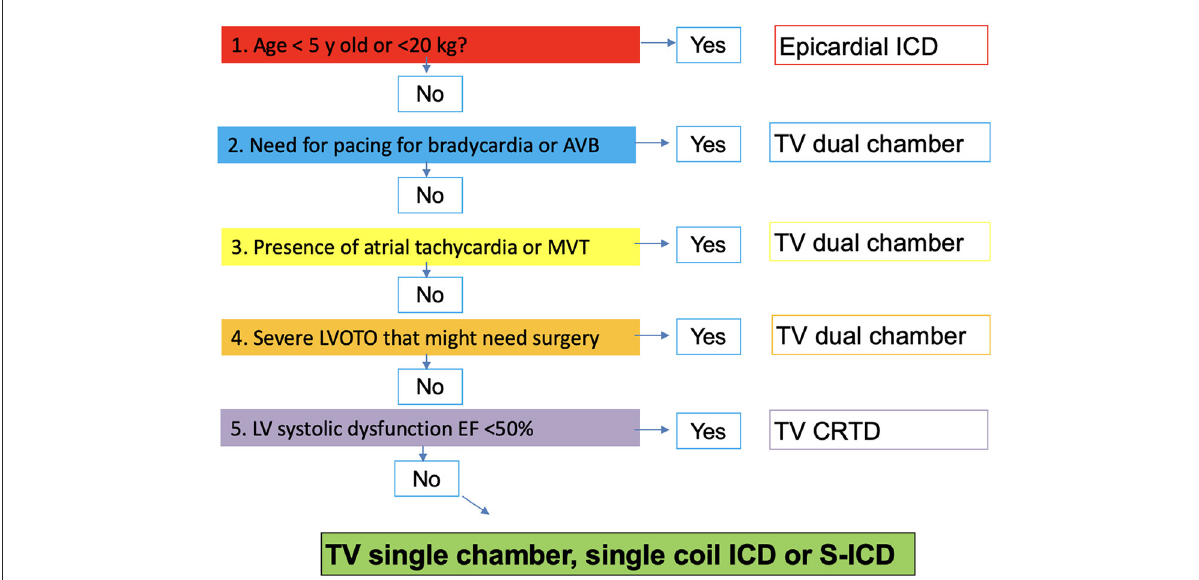
FIGURE4 Stepwise approach to guide selection of type of ICD implant in children with hypertrophic cardiomyopathy. ICD, implantable cardiac defibrillation; AVB, Atrioventricular block; TV, Transvenous; MVT, Monomorphic Ventricular tachycardia; LVOTO, Left ventricle outflow tract obstruction; CRTD, Cardiac resynchronisation therapy with defibrillation; S-ICD, Subcutaneous